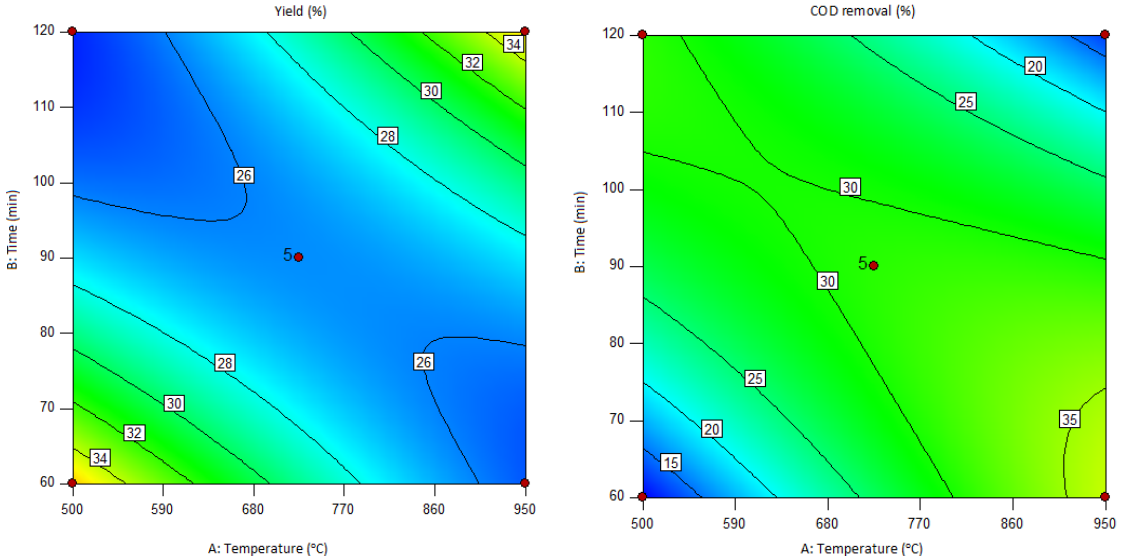
Fig. 3: Time and temperature effects on biochar yield (%) Fig. 4: Time and temperature effect on COD removal (%)